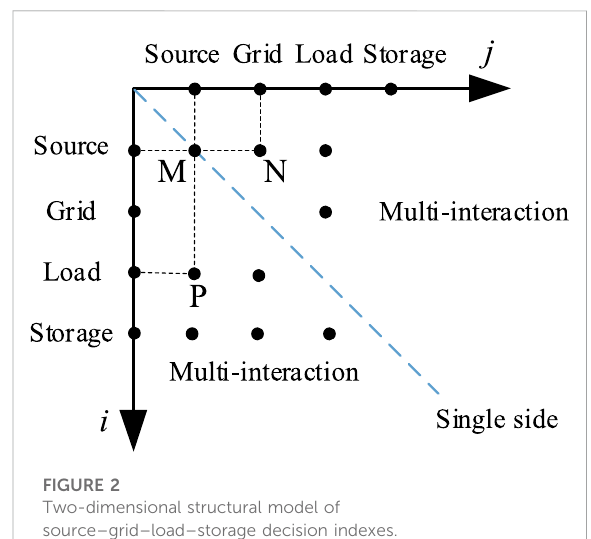
FIGURE 2 Two-dimensional structural model of source – grid – load – storage decision indexes.